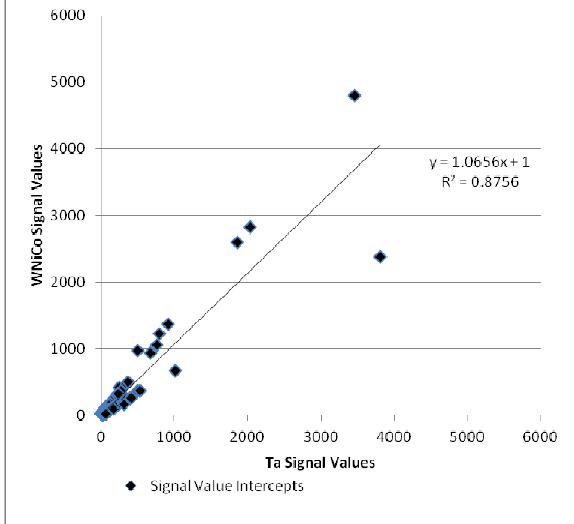
Figure 5. Plot of WNiCo and Ta signal values for fold change ≥ 1.35 and ≤